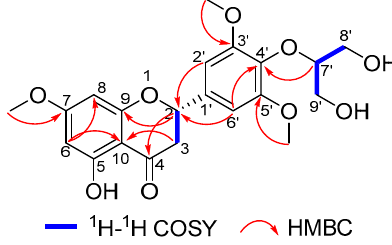
Figure 2. 1 H– 1 H COSY and key HMBC correlations of 1.